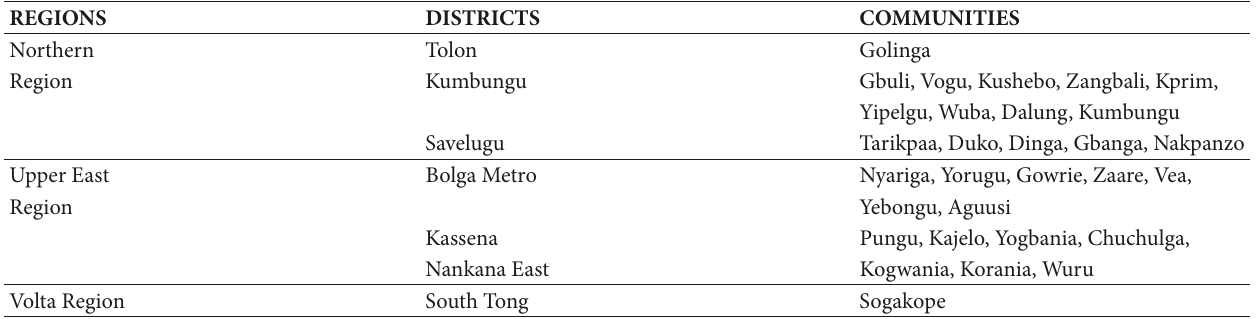
Table 1: Study regions, districts, and communities.